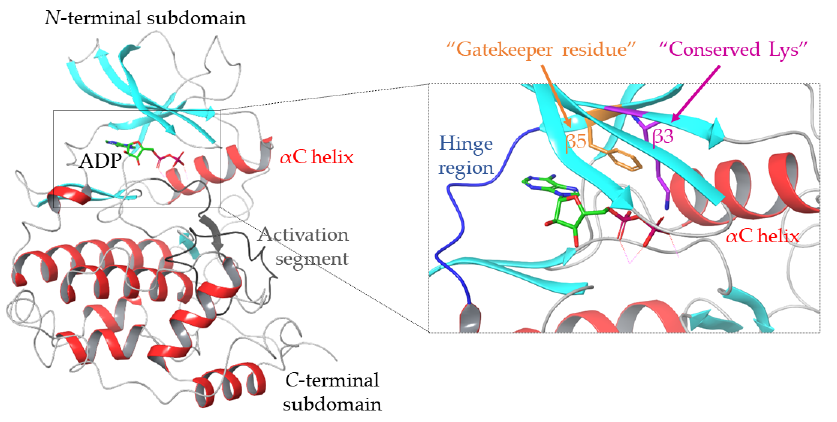
Figure 1. Crystal structure of the protein kinase CK2 α -subunit with ADP bound in the catalytic site (PDB: 6YPN). α -helices are in red; β -strands are in cyan; the activation segment is in dark grey; the hinge region is in blue; the conserved Lys in the β 3-strand (Lys68) is in magenta; the gatekeeper residue in the β 5-strand (Phe113) is in